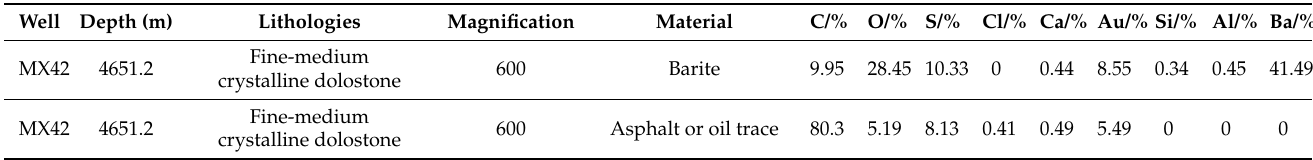
Table 1. Elemental composition of asphalt and barite.